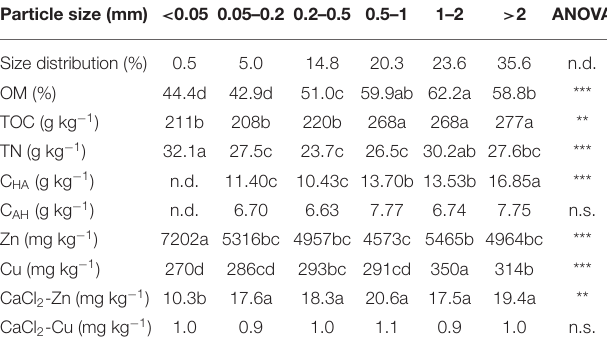
TABLE 4 | Characteristics of the different particle size fractions in Compost 2.